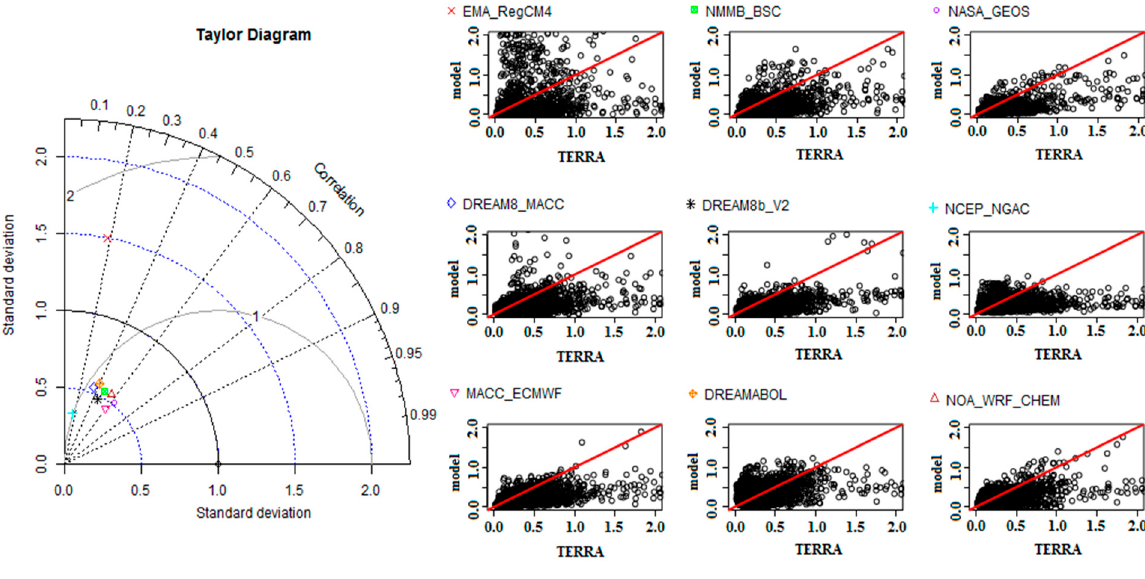
Figure 11. Taylor diagram and scatter plots of AOD values from model outputs and Terra-MODIS observations over the Middle East during Shamal dust storms. According to the combined results summarized in Table 2 and Figure 12, in general, the highest correlation coefficient is related mostly to NASA_GEOS and DREAM8_MACC models, both of which used MODIS data assimilation schemes (Appendix A). These re- sults indicate that even though the model forecasts correspond to valid time more than 24 h after the initial time, the effect of data assimilation increases the accuracy of the forecasts. These two models also have a relatively high resolution compared to other examined models. NOA-WRF-Chem also presented satisfactory results with lower RMSE values compared to other models. Although the NCEP_NGAC model has finer resolution than MACC_ECMWF model, its outputs were less accurate. The various models exhibited higher correlation coefficients and lower RMSE values (Table 2, Figure 12) for the cyclonic dust storms compared to frontal dust storms. The larger inaccuracies in the predictions of